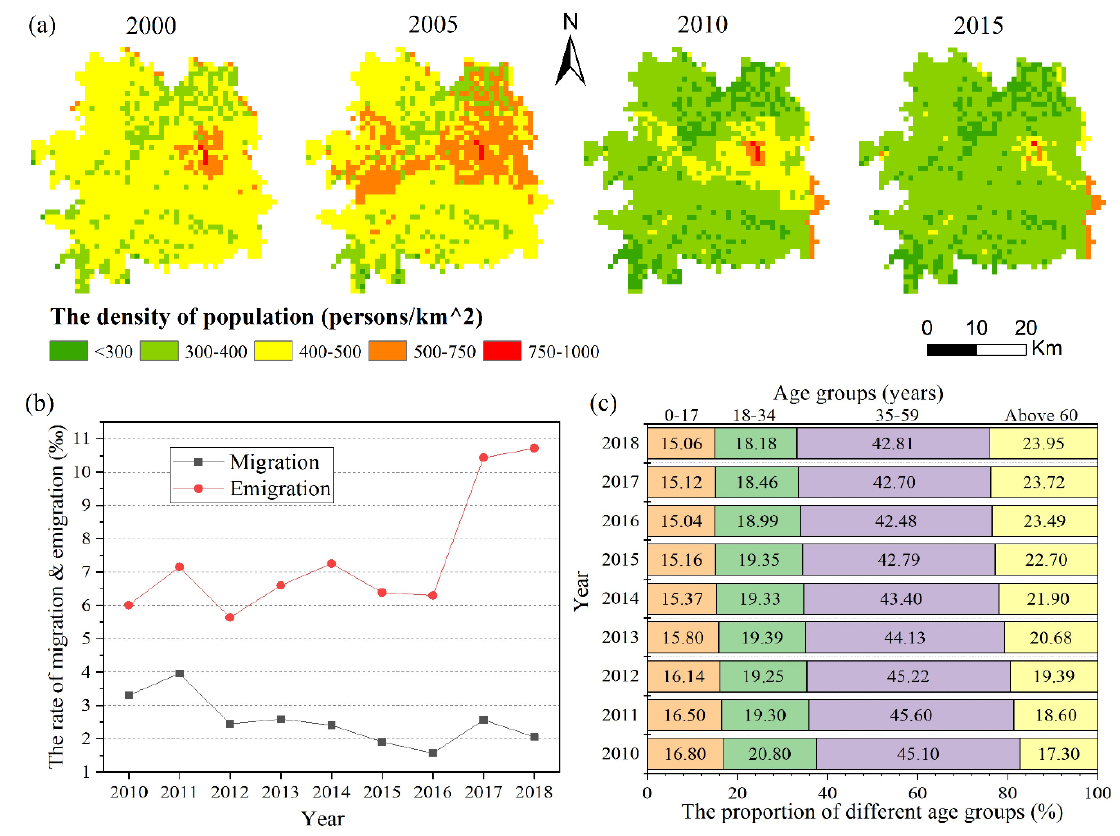
Figure 7. ( a ) The spatial distribution map of the population density of Rong County in 2000, 2005, 2010, and 2015 (source: [52]); ( b ) the annual rate of migration and emigration in Rong County during